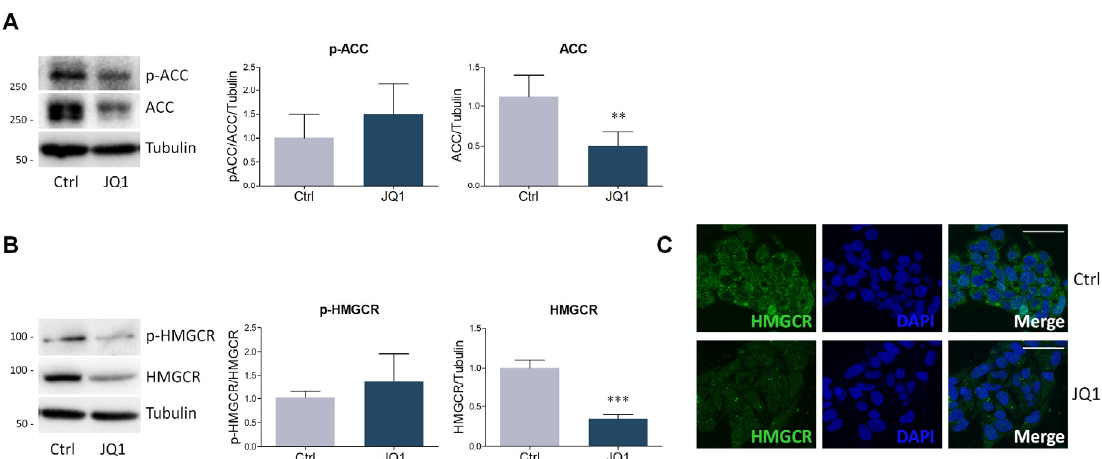
Figure 2. Evaluation of BET inhibition on lipid biosynthesis enzymes. ( A ) Representative Western blot (left panel) and densitometric analysis of phosphorylated Acyl Coenzyme A carboxylase (ACC) (P-ACC, ser79) and total ACC in HepG2 cells treated with vehicle (Ctrl) or JQ1 (0.4 µM) for 48 hours. n = 6 independent experiments. Tubulin was employed as a housekeeping protein to normalize protein loading. ( B ) Representative Western blot (left panel) and densitometric analysis (right panel) of phosphorylated 3-hydroxy-3-methylglutaryl Coenzyme A reductase (HMGCR) (p-HMGCR, ser872) and total HMGCR in HepG2 cells treated with vehicle (Ctrl) or JQ1 (0.4 µM) for 48 hours. n = 7 independent experiments. Tubulin served as a housekeeping protein to normalize protein loading. ( C ) Immunofluorescence staining of HMGCR (green) of HepG2 cells treated as in (B). Nuclei were counterstained with DAPI. n = 3 different experiments. Scale bar: 50 µm. Data are expressed as means ± SD. Statistical analysis was carried out by using unpaired Student’s t test. ** p < 0.01; *** p < 0.001.